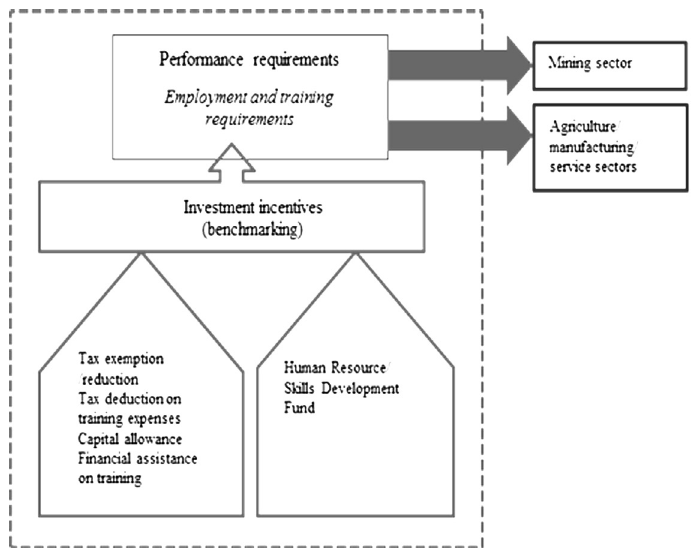
Figure 2. Option two: Using performance requirements and investment incentives